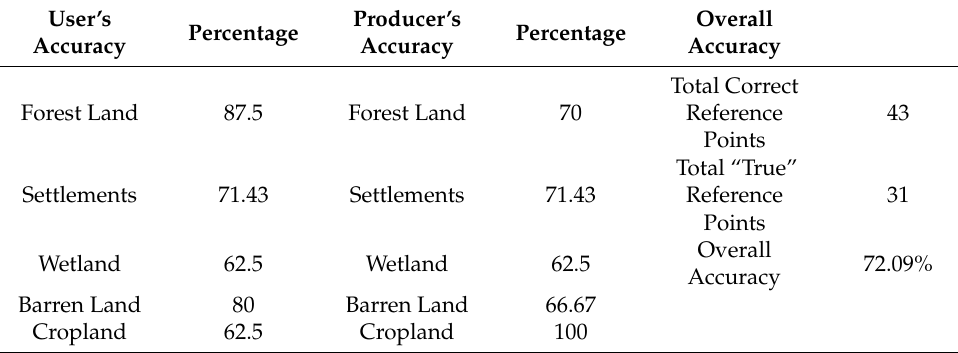
Table 10. User’s, producer’s accuracies and overall accuracy of the classified imagery of